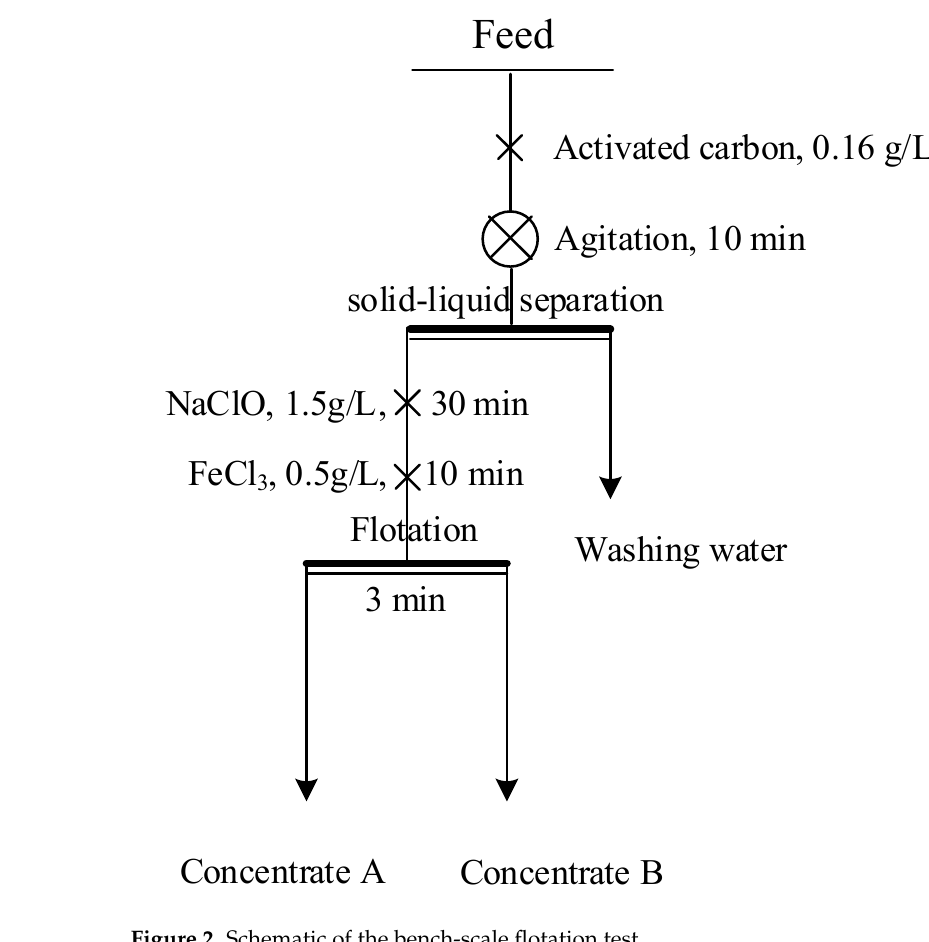
Figure 2. Schematic of the bench ‐ scale flotation test.